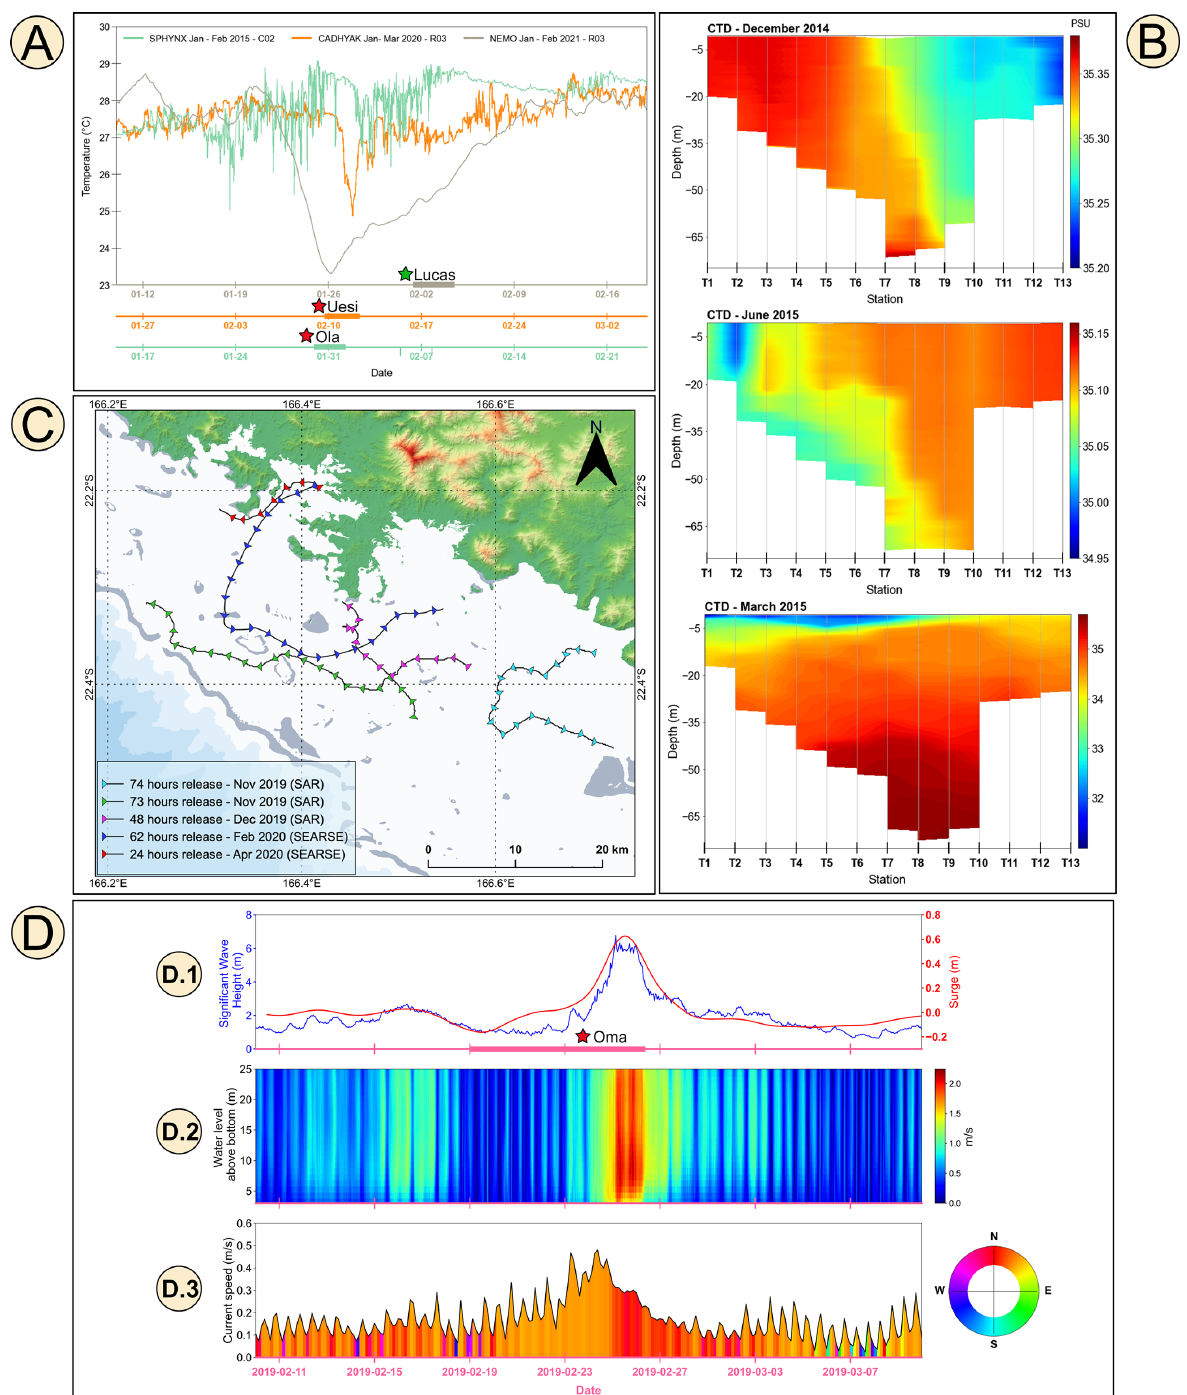
Figure 5. Overview of some physical and hydrodynamical processes occurred over PRESENCE project: (a) presentation of temporal varia- tion of temperature during SPHYNX, CADHYAK, and NEMO campaigns. (b) Cross-shore expansion and vertical stratification of salinity in Hienghène–Touho lagoon (SPHYNX campaign). (c) Lagrangian circulation recorded with reef drifters in Nouméa area (SEARSE and SAR experiments). (d) Cross-reef and passage circulation in Poé lagoon (ELADE campaign): (d.1) significant wave height (Hsig) at O2 station and surge at L13 station; (d.2) current speed over water column in the Shark fault (P01 station); and (d.3) current speed measured inside lagoon at L06